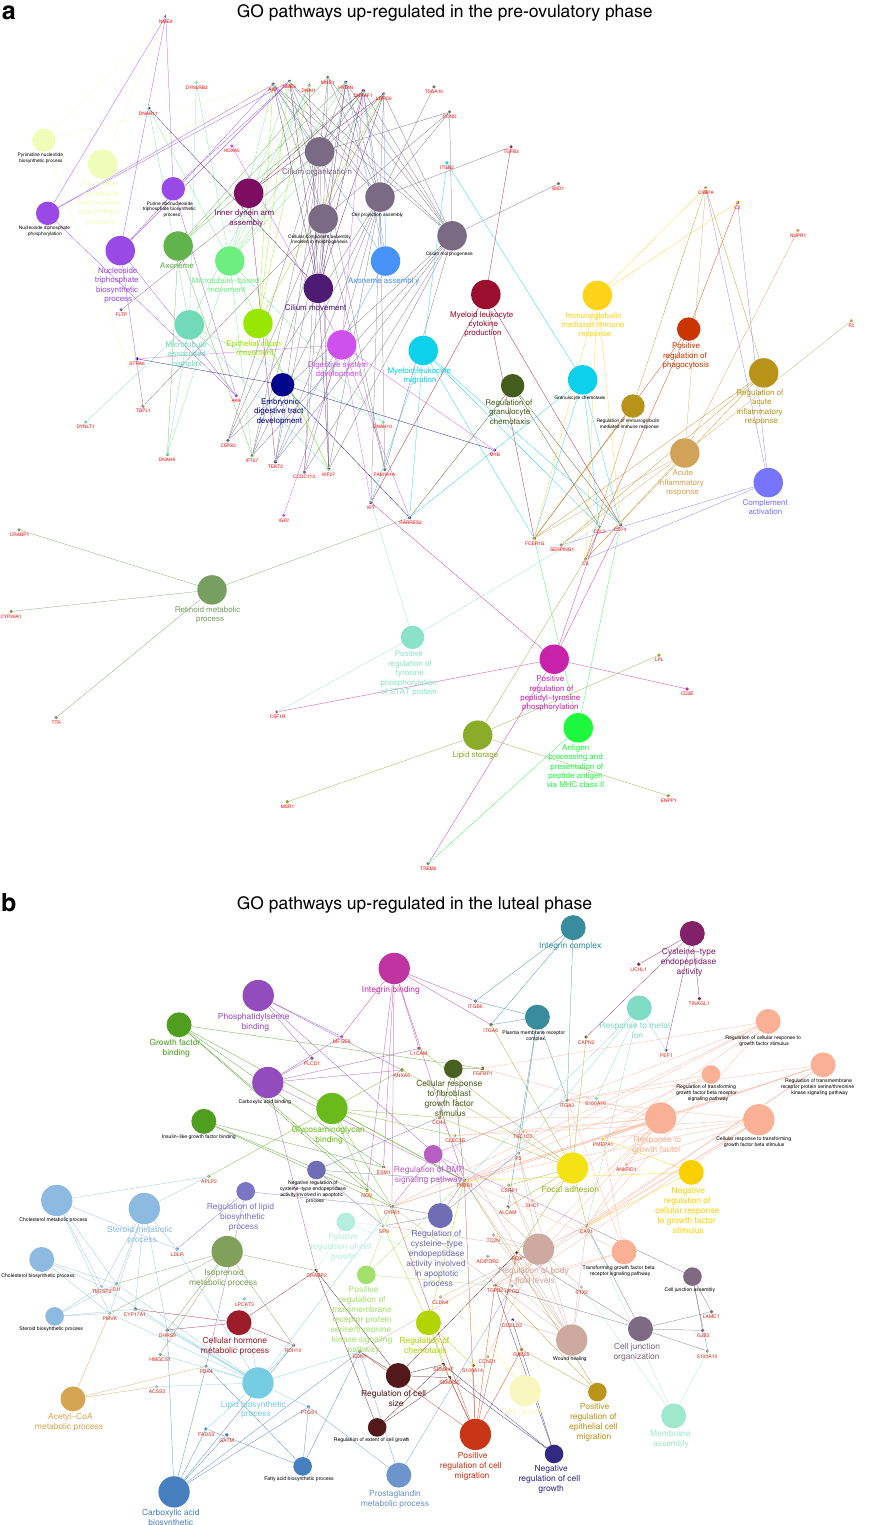
Fig. 4 Functionally grouped gene ontology (GO) terms for upregulated or downregulated gene expression in simulated pre-ovulatory and luteal phases. The CytoScape plugin ClueGO was used to group the genes into functional GO terms of “ molecular processes ” and “ biological processes ” . a Upregulated GO pathways in the pre-ovulatory phase; and b upregulated GO pathways in the luteal